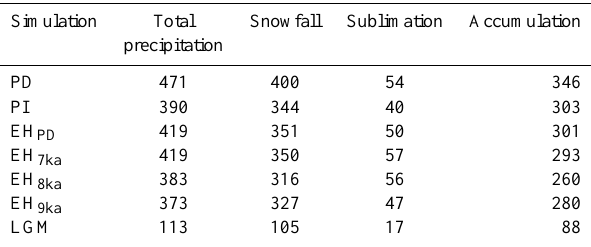
Table 2. Annual means of hydrological parameters in [mmyr − 1 ] averaged over the Greenland Ice Sheet.